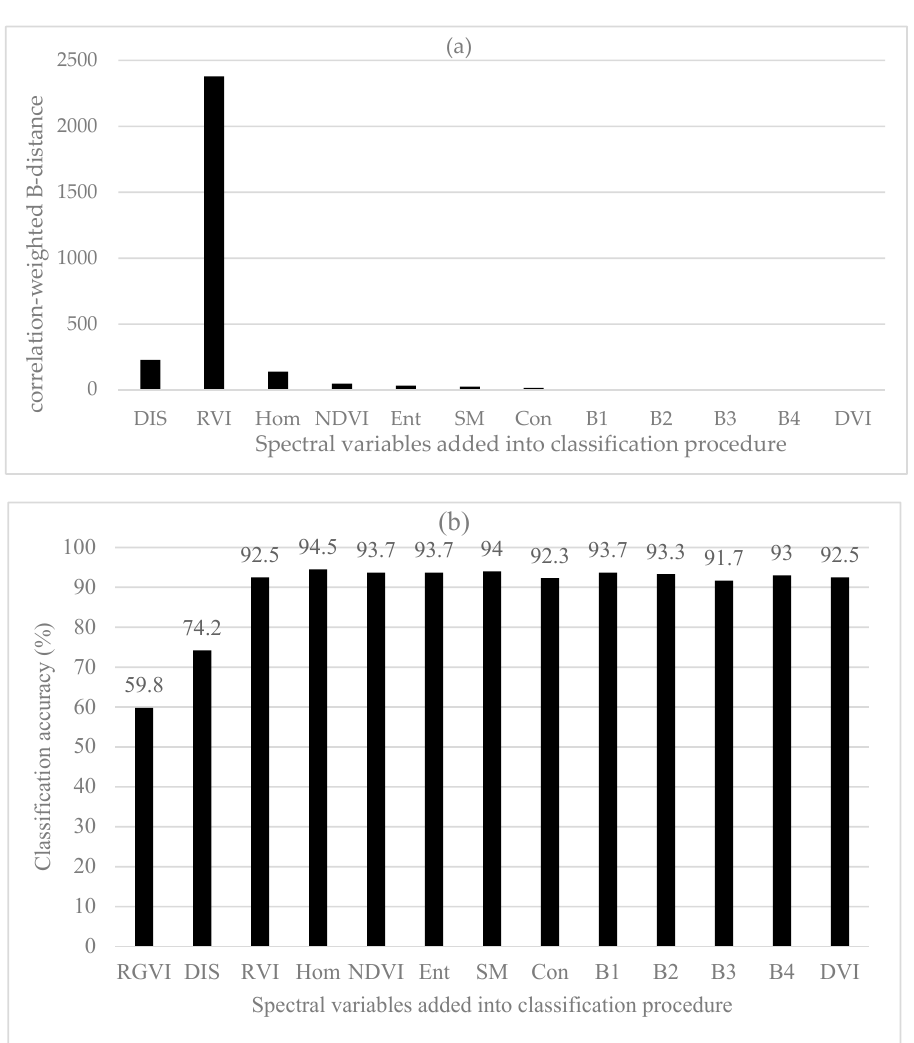
Figure 7. ( a ) Correlation-weighted B-distances of the left 12 spectral variables selected after the first spectral variable RGVI (Note: the values of B1, B2, B3, B4 and DVI were 0.39, 0.17, 0.11, 0.09 and 0.08, respectively and could not be shown because of too small values); and ( b ) the classification accuracies of six land cover types using Bayesian discriminant ( BD ) classifier as spectral variables were added based on correlation-weighted B-distances.